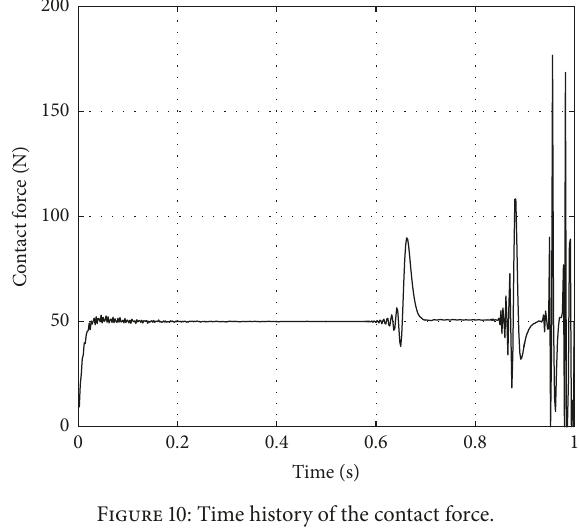
Figure 10: Time history of the contact force.